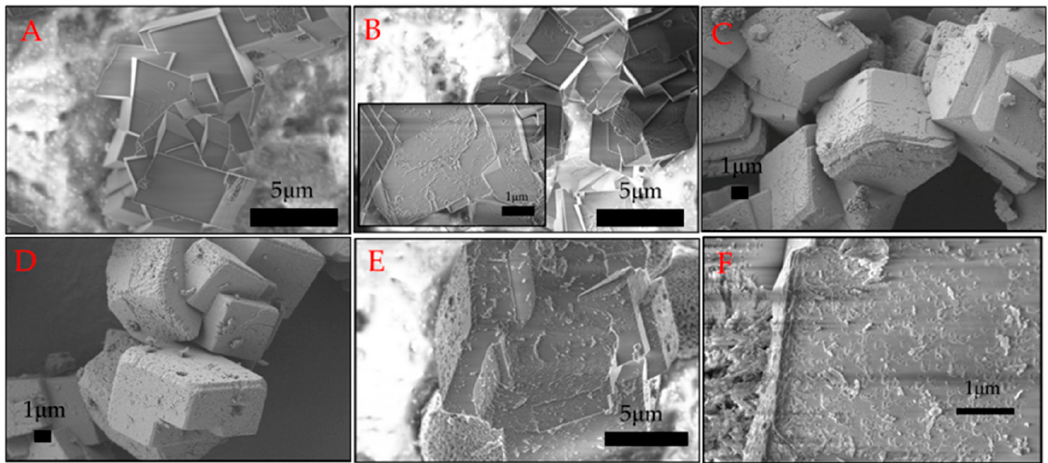
Figure 3. SEM images of calcium carbonate precipitation at various surfactin concentrations after 24 h of ageing. ( A ) control sample, ( B ) 5 ppm, ( C , D ) 10 ppm, ( E , F ) 20 ppm of surfactin. The concentration of CaCl 2 and Na 2 CO 3 was 5mM.